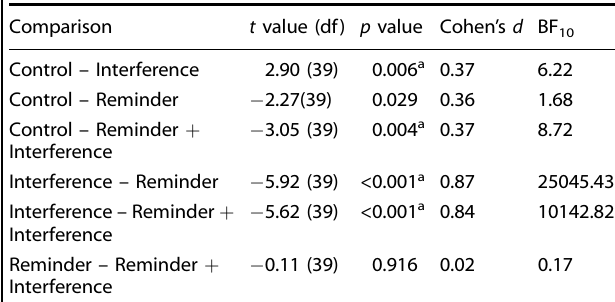
Table 1. Post-hoc paired samples t-tests comparing conditions on accuracy (with Cohen ’ s d effect size and Bayes factors included).